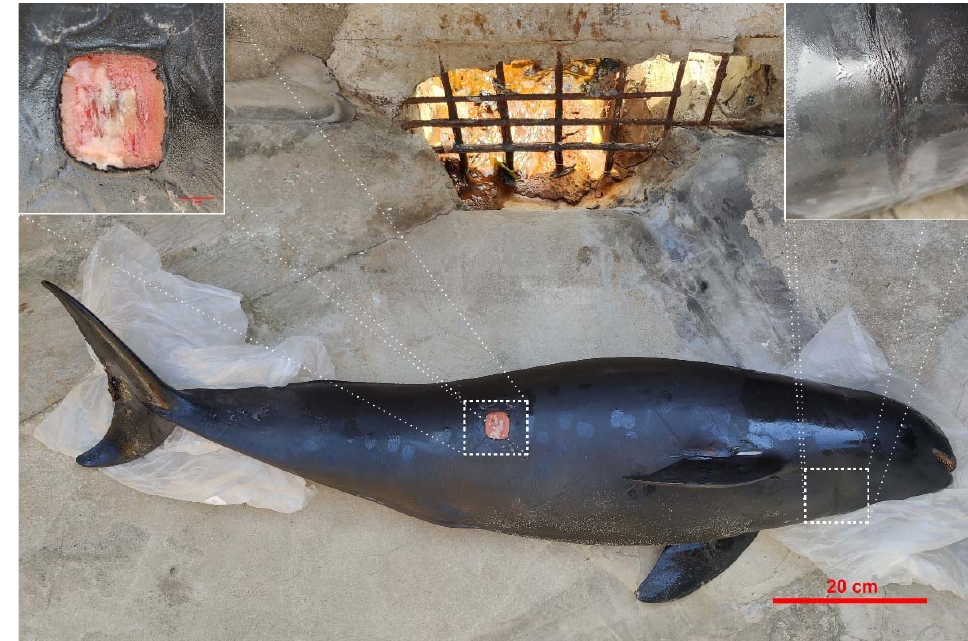
Figure 1. Image of the stranded Indo-Pacific finless porpoise.